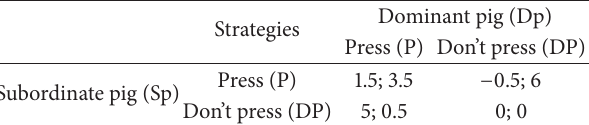
Table 2: Boxed Pigs model, as in [9].